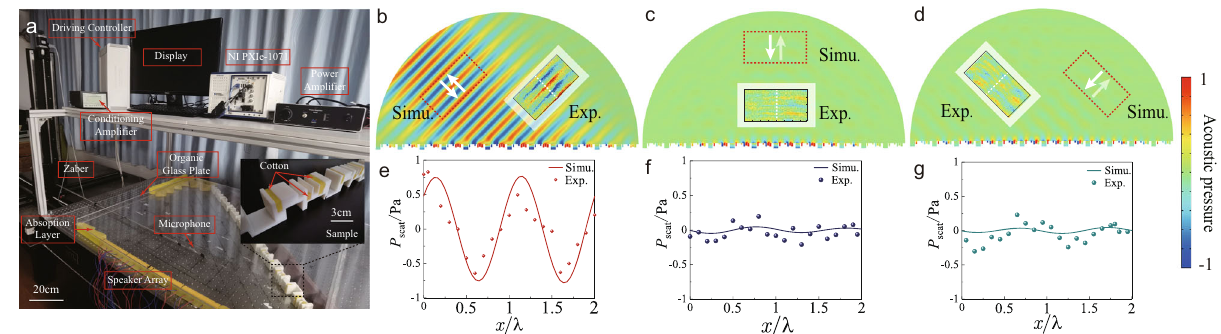
Fig. 5 Experimental demonstration of the third-order exceptional point (EP). a Experimental platform and the metagrating sample attached with melamine cotton. Simulated and experimental results (re fl ected fi eld) of the multi-channel metagrating at the third-order EP under left ( b ), normal ( c ), and right ( d ) incidences. In each case, the scanning region is marked by a dotted-line box in the simulated wave fi eld. The propagating waves are represented by white arrows while the less-visible arrows indicate the suppressed retro-re fl ection waves. For comparison, the measured re fl ected fi elds are shown with white borders on the side. e – g The simulated (lines) and measured (dots) pressure distributions along the center line of the scan area, as presented with white dotted lines in the upper panel. λ is the wavelength of the working frequency.